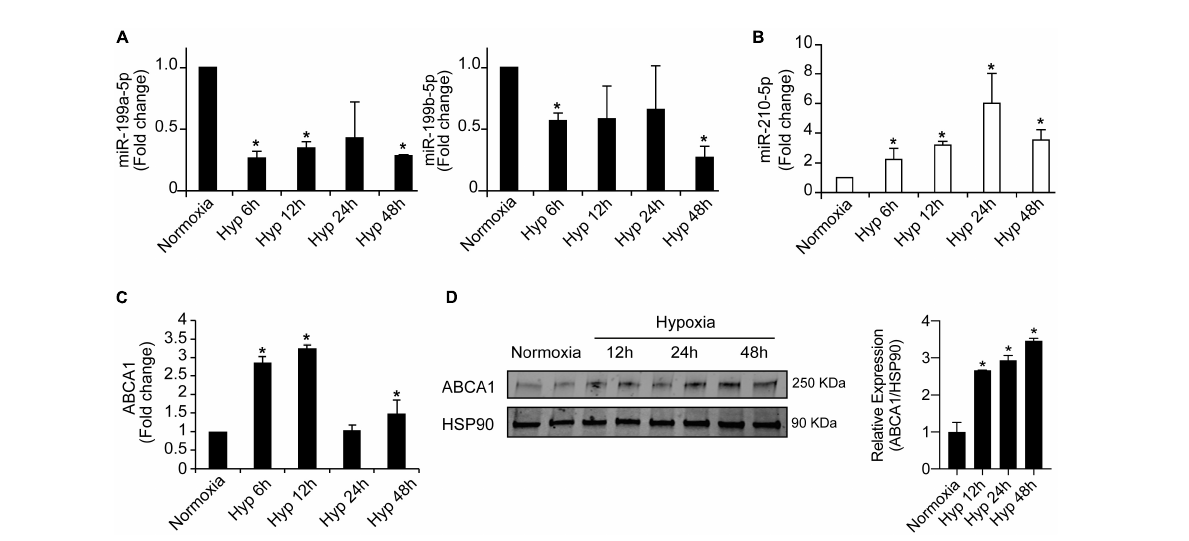
FIGURE5 Inverse regulation of miR-199a-5p and ABCA1 during hypoxia. (A) qRT-PCR analysis of miR-199a-5p, and miR-199b-5p expression levels in mouse peritoneal macrophages stimulated with hypoxia at the indicated time points. (B) miR-210-5p was used as a positive control of hypoxia. (C) qRT-PCR analysis of ABCA1 in mouse peritoneal macrophages subjected to hypoxia at the indicated time points. (D) Representative Western blot of ABCA1 in mouse peritoneal macrophages under hypoxia at the indicated time points. HSP90 was used as a loading control. Right panel shows relative ABCA1 protein expression normalized to HSP90 ( n = 3). Data are expressed as relative expression and correspond to the means ± SEM from three independent experiments. * P < 0.05, significantly different from cells in